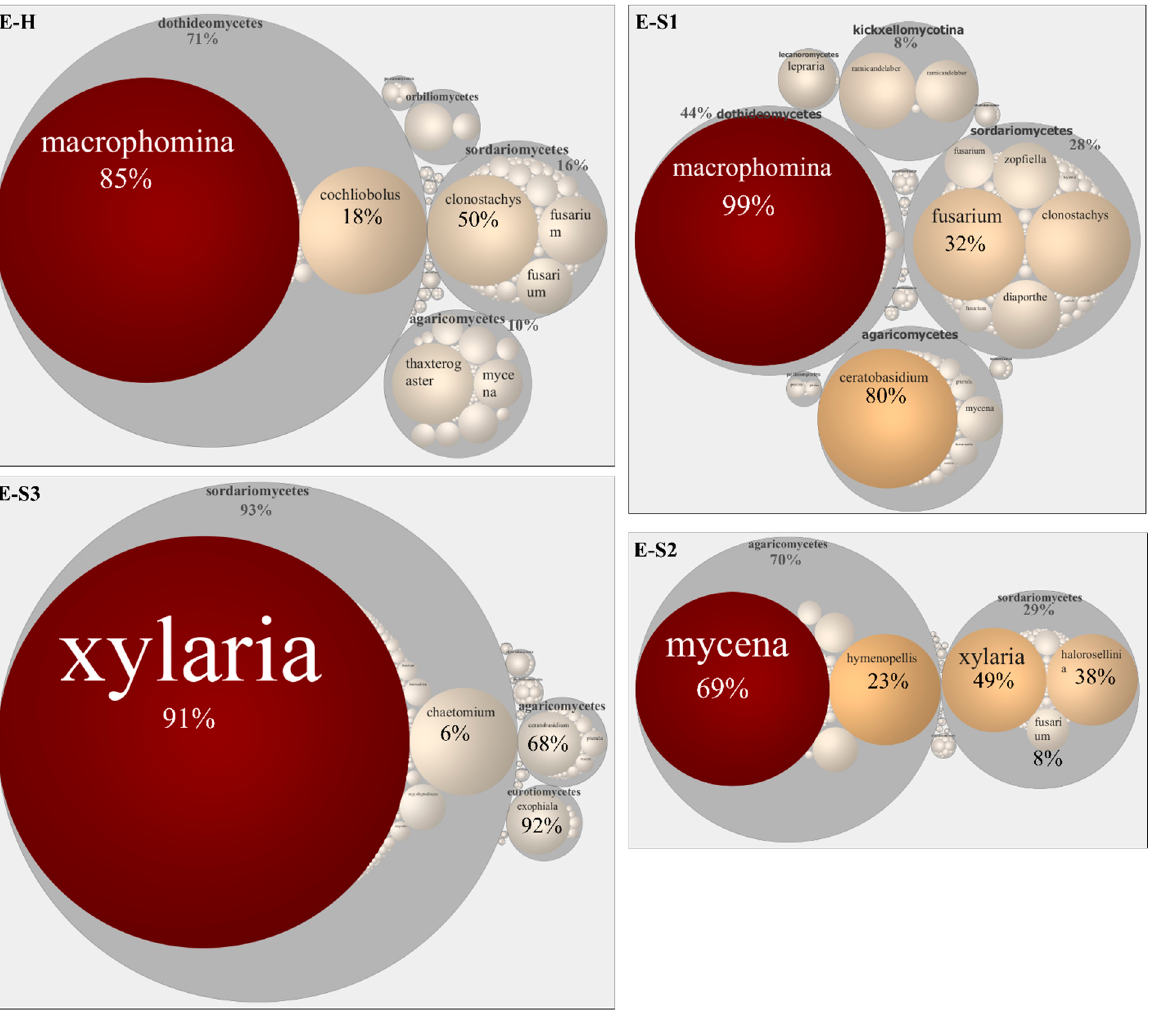
Figure 4. Taxonomic circular maps of soybean fungal root endophytes. Taxonomic analyses of the endophytes (E) in healthy (H) and TRD-affected roots (S1 to S3) are based on ITS rRNA sequencing and OTUs with the highest abundance ( n > 0.2%). The taxa are grouped by class; the labels show the most abundant genera. The size of the map circles is proportional to the reads number. The arrows point to the position of Xylariaceae. Numbers depict percentages of selected taxonomical